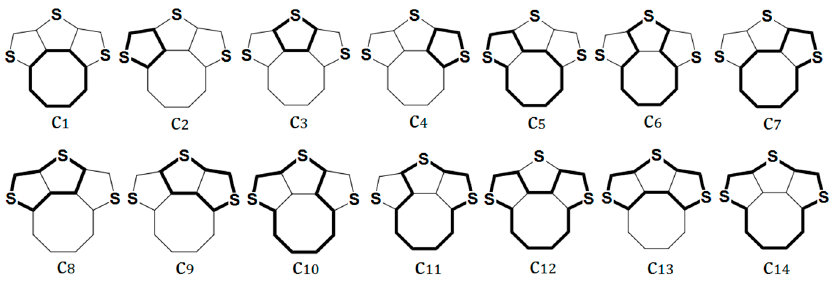
Figure 4. The geometrically non-identical π -electron circuits in compound 1 . The specific circuits studied are shown in bold. Reprinted with permission from Ref. [51]. Copyright 2018 Springer.